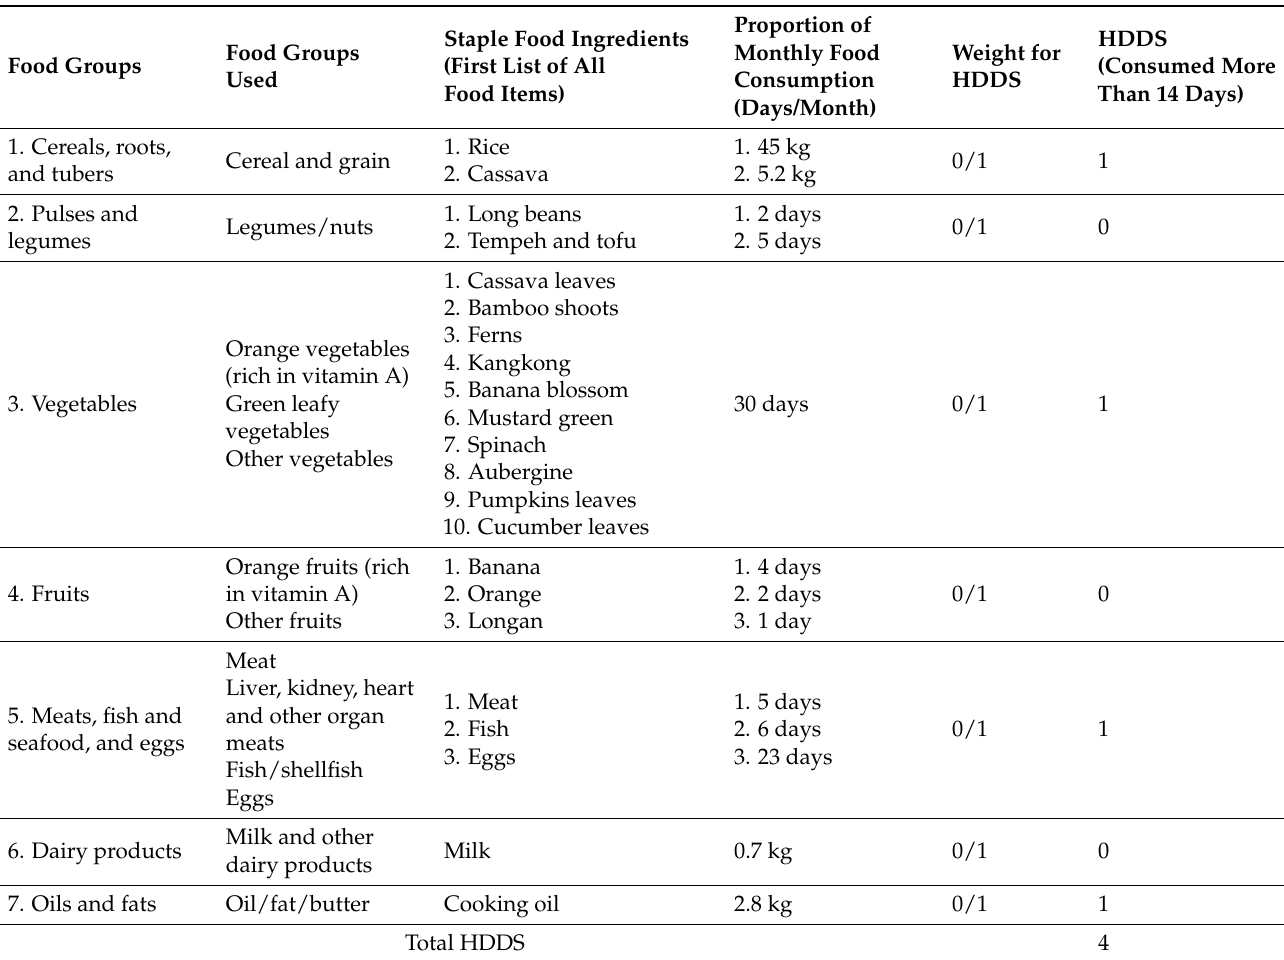
Table 10. Current HDDS of the community in the Ruis